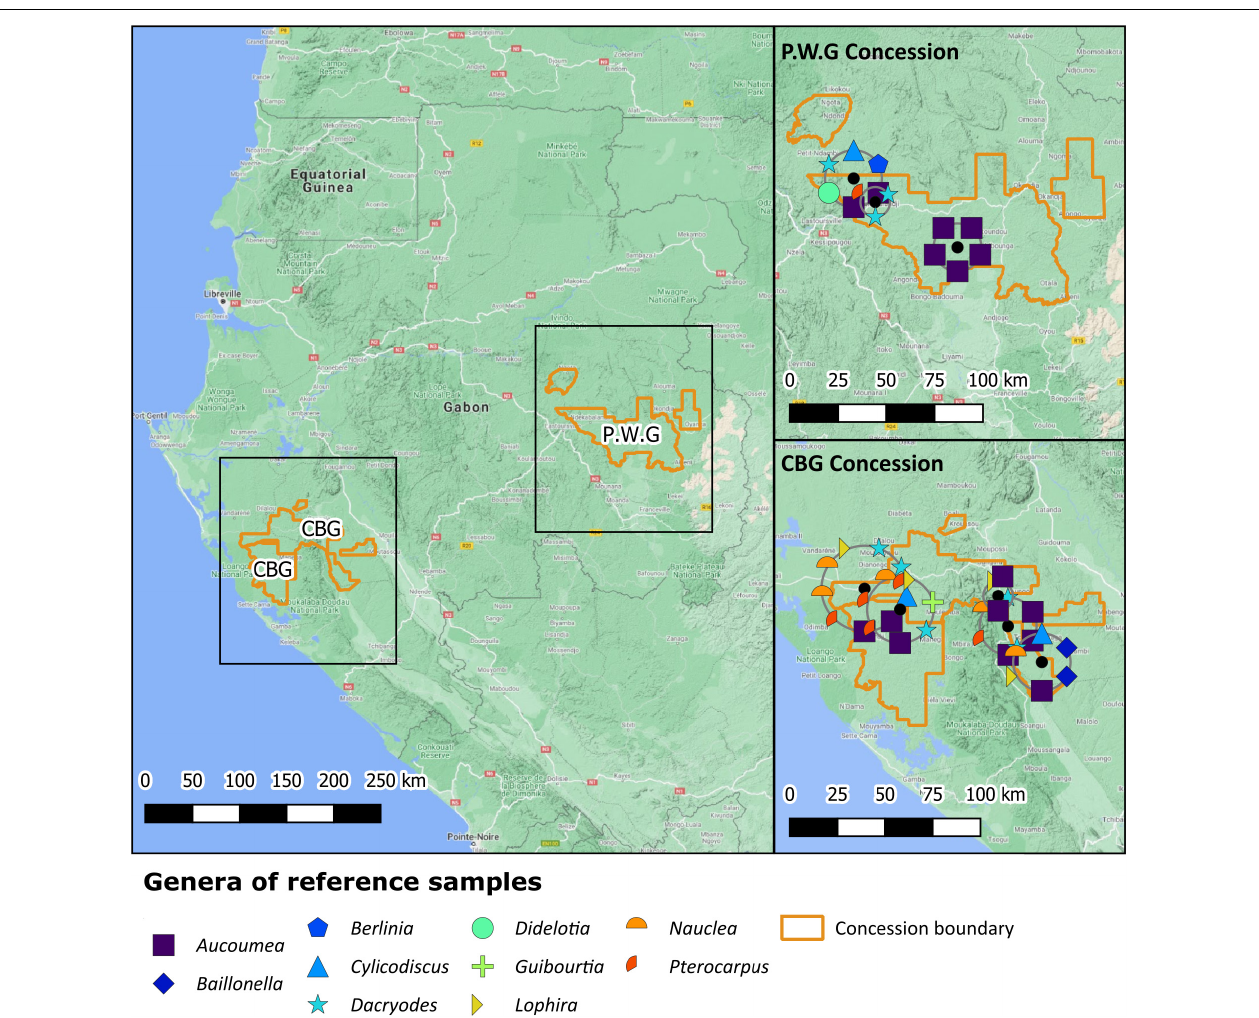
FIGURE 1 | Locations and taxa of samples collected in the C.B.G and P.W.G concessions in Gabon. The positioning of location markers is displayed using point displacement. The black dots represent the centroid of the sample